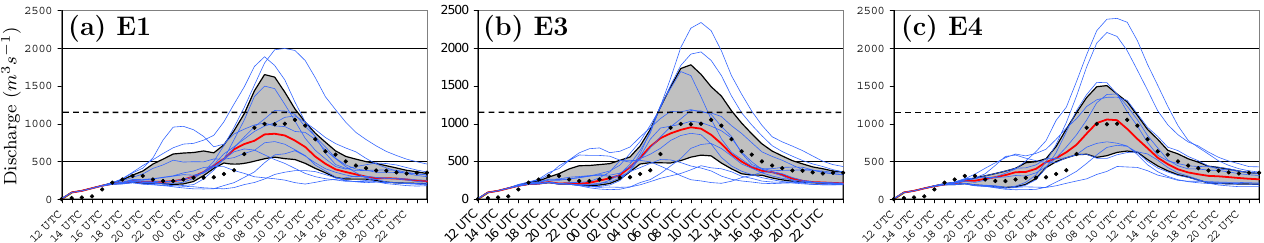
Fig. 13. Observed and forecast hydrological discharge for the Gardons river for Case 3, from 12:00 UTC 1 November 2008 to 00:00 UTC 3 November 2008, for the (a) E1, (b) E3 and (c) E4 ensembles. Hourly observed discharge is plotted as black diamonds, blue lines stand for each ensemble member, the ensemble median is shown in red. The grey shading represents the interquartile range. Dashed lines represent the discharge for a reference flood on each watershed.